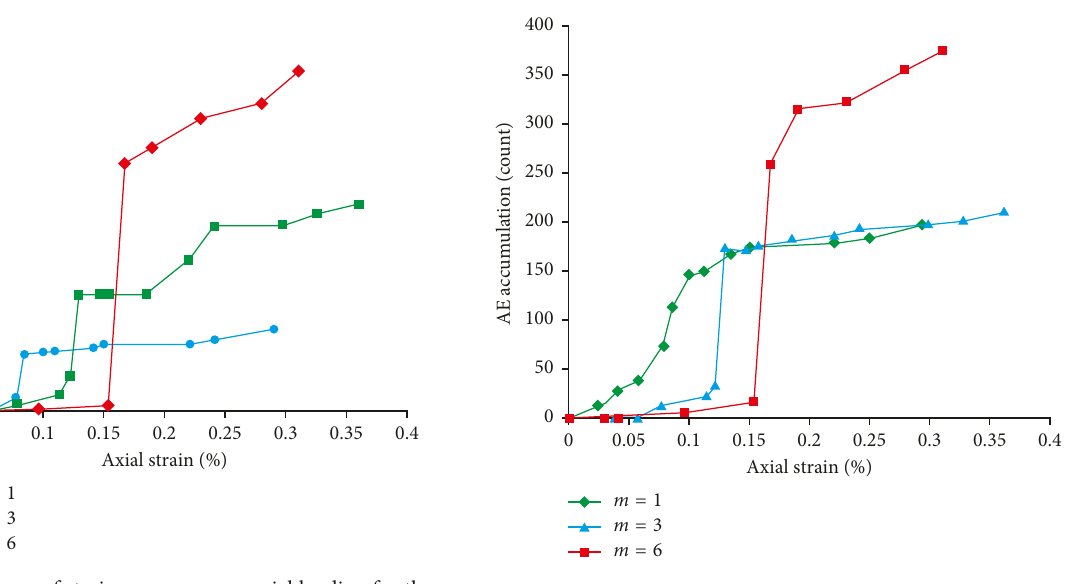
Figure 17: The AE accumulation counts versus axial loading for the numerical specimens with different homogeneity